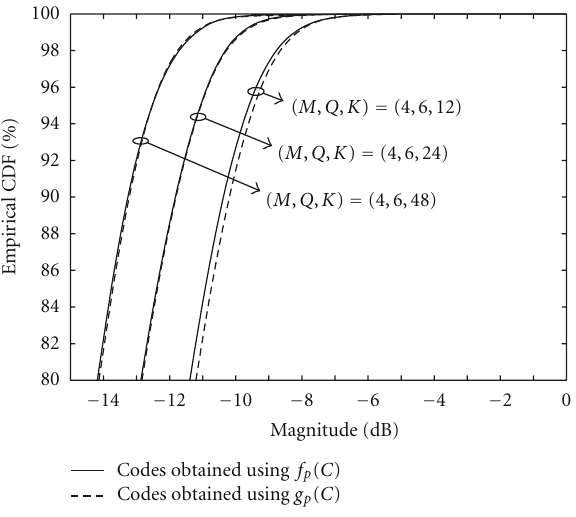
Figure 8: Empirical CDF of | Ω ( τ , ν , f , f (cid:6) ) | .